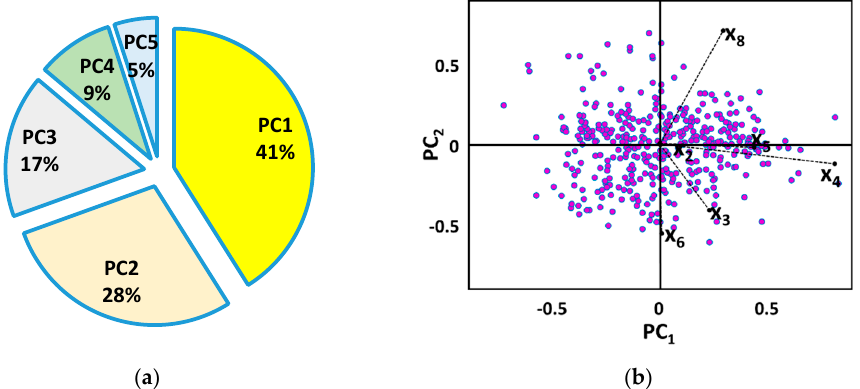
Figure 4. ( a ) Variance in the five most influential principal components and ( b ) the relationship between the two variables and PC2.